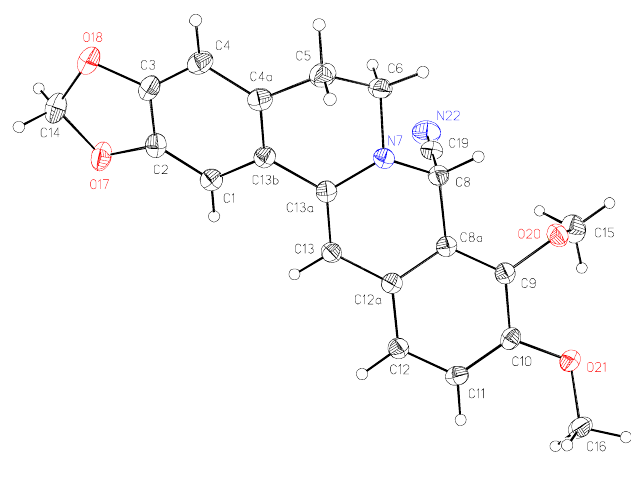
Figure 3. A perspective view of 8-cyano-8 H -berberine ( 2 )